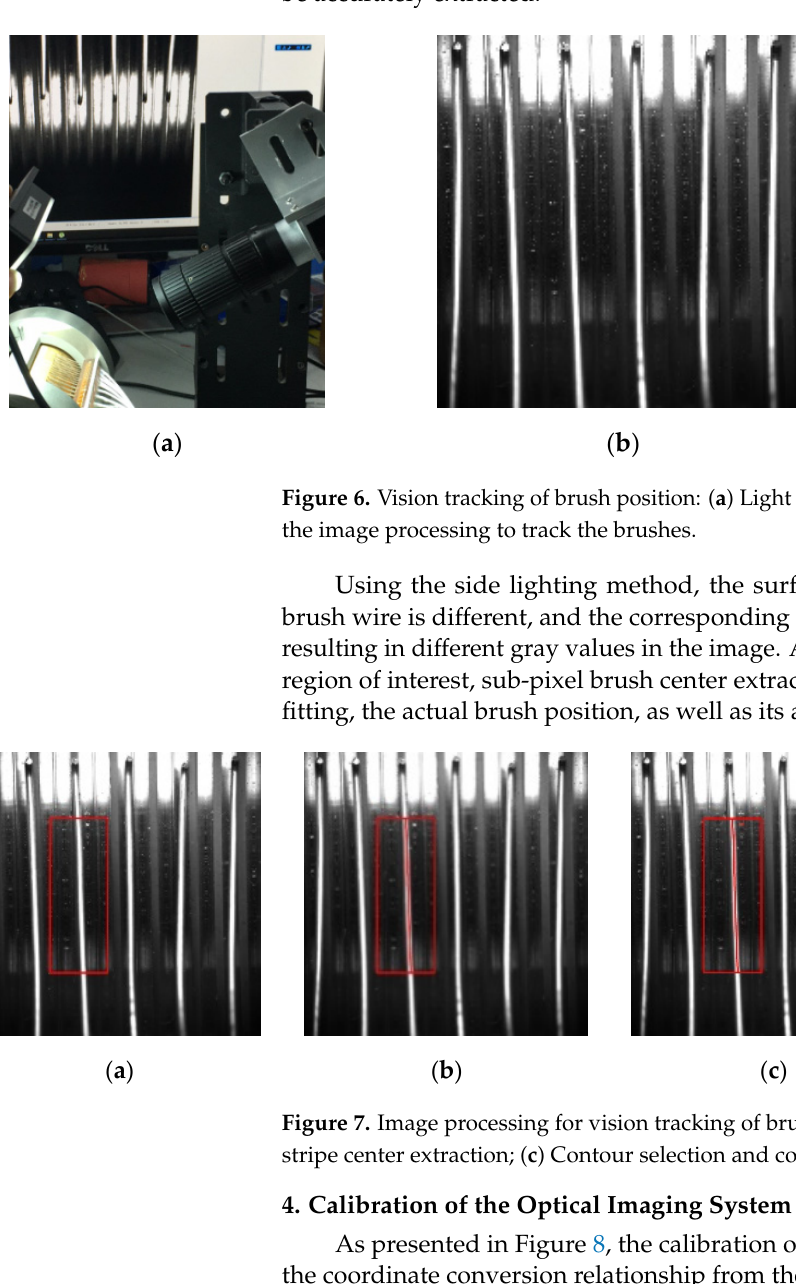
p Figure 8. Calibration projection relation of optical imaging system. The calibration model of the optical imaging system is based on the pinhole model, and its mathematical expression is represented as follows [20]: 0 0 0